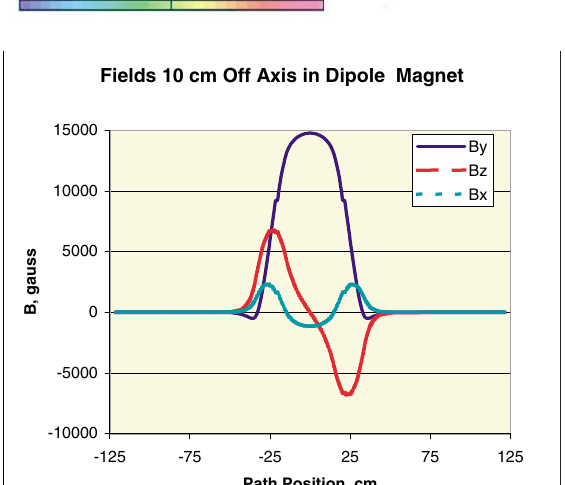
and the calculated field 2